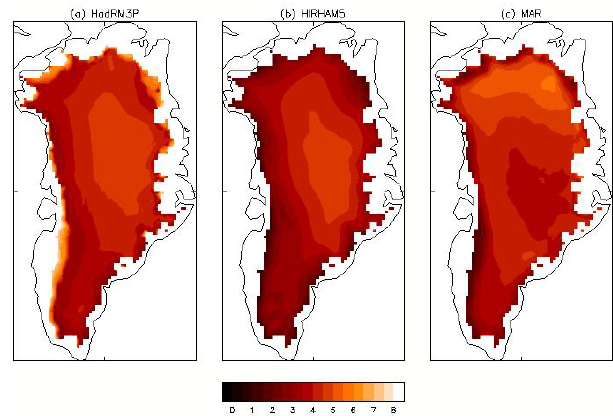
Fig. 11. 2080–2099 T as anomalies ( ◦ C), relative to 1980–1999, over the GrIS in ECHAM5-A1B-forced simulations. (a) HadRM3P, (b) HIRHAM5, (c) MAR.